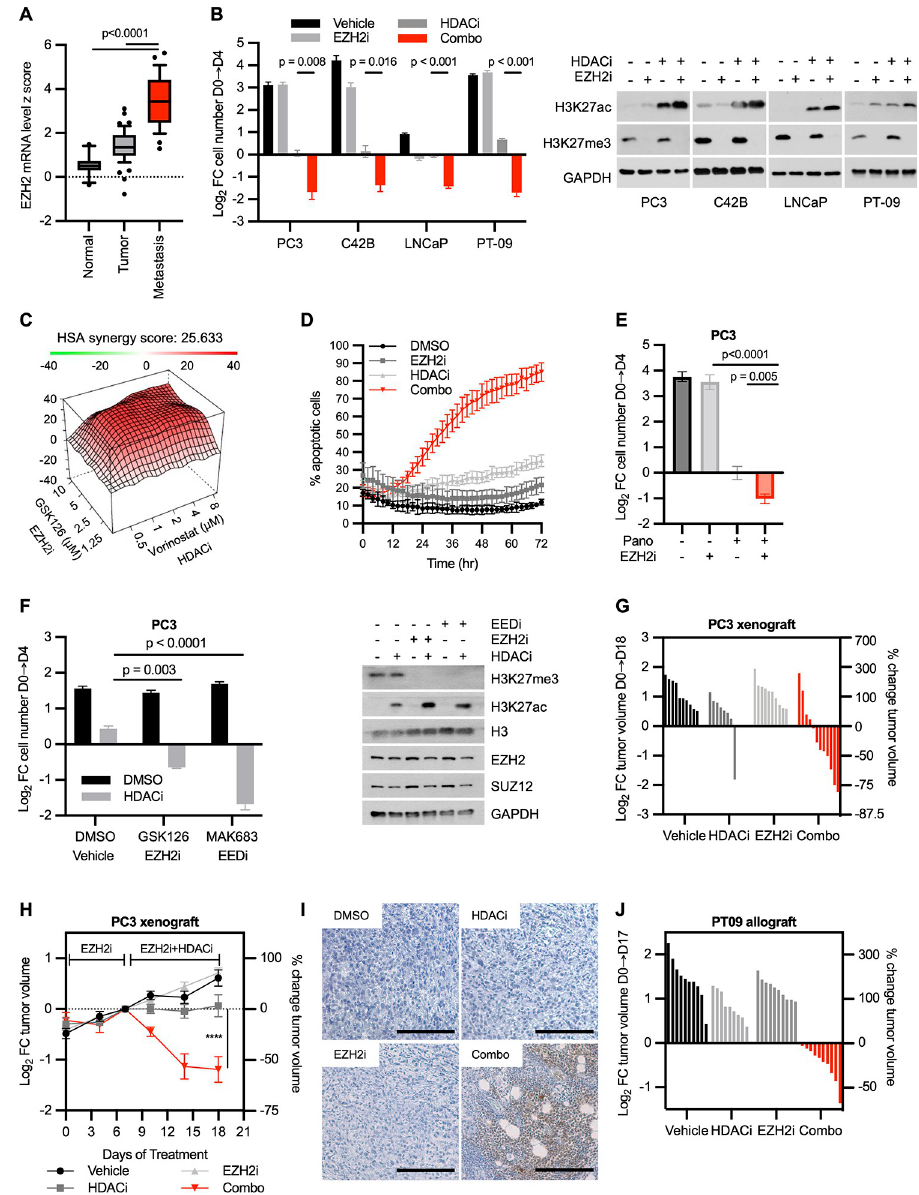
Fig 1. Combined EZH2 and HDAC inhibitors kill CRPC cells and trigger regression of CRPCs in vivo. (A) Box plot displaying z score values of EZH2 mRNA expression in normal prostate, primary prostate adenocarcinoma, and metastatic prostate cancer tumors. Data obtained from Grasso and colleagues [45] (S1 Data). ( B) Bar graph illustrating the cytotoxic effects of EZH2 and HDAC inhibitors. Three human prostate cell lines (PC3, C42B, and LNCaP) and one mouse cell line (PT-09) were treated with DMSO, 5 μ M GSK126 (EZH2i), 2 μ M vorinostat (HDACi), or both agents combined as described. Manual cell counting was performed on day 0 and on day 4 after combined treatment. Graphs (left) show log 2 FC in cell number on day 4 compared to day 0. Immunoblots (right) confirm target inhibition (S1 Data). ( C) Synergy plot using Gaddum’s noninteraction model (HSA) for PC3 cells treated with EZH2i (GSK126) and/or HDACi (vorinostat). Plot is representative of 3 replicates. ( D ) Graph depicting percentage of caspase 3/7+ (apoptotic) cells over time using Incucyte live cell imaging (S1 Data). ( E) Bar graph illustrating the cytotoxic effects of panobinostat and GSK126. PC3 cells were treated with DMSO, 5 μ M GSK126 (EZH2i), 20 nM Panobinostat (Pano), or a combination of the 2 inhibitors. Log 2 FC was calculated as in Fig 1B (left) (S1 Data). ( F ) Bar graph illustrating the cytotoxic effects of combined EED/HDAC inhibitors. PC3 cells were treated with DMSO, 2 μ M vorinostat (HDACi), 5 μ M GSK126 (EZH2i), 5 μ M MAK683 (EEDi), or combined agents as denoted. Log 2 FC was calculated as in Fig 1B (left) (S1 Data). Immunoblots (right) show target inhibition in each experimental group at 24 hours posttreatment. ( G ) Waterfall plot depicting log 2 FC in tumor volume of PC3 xenografts after 18 days of treatment with EZH2i (GSK126) and/or HDACi (vorinostat). ( n = 8–12 per arm) (S1 Data). ( H ) Tumor growth curve